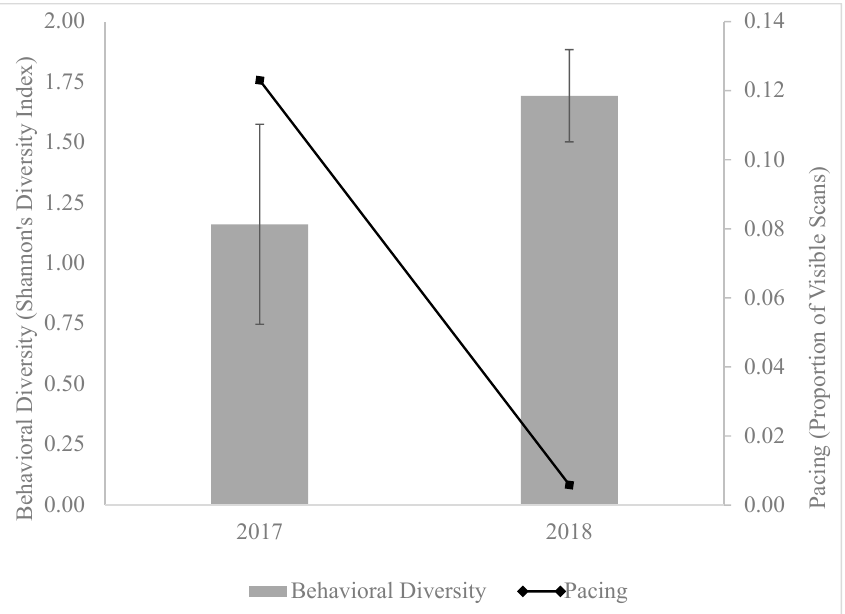
Figure 1. Behavioral diversity and pacing behavior of Amur leopard before and after utilizing outcome-based behavior workflow.